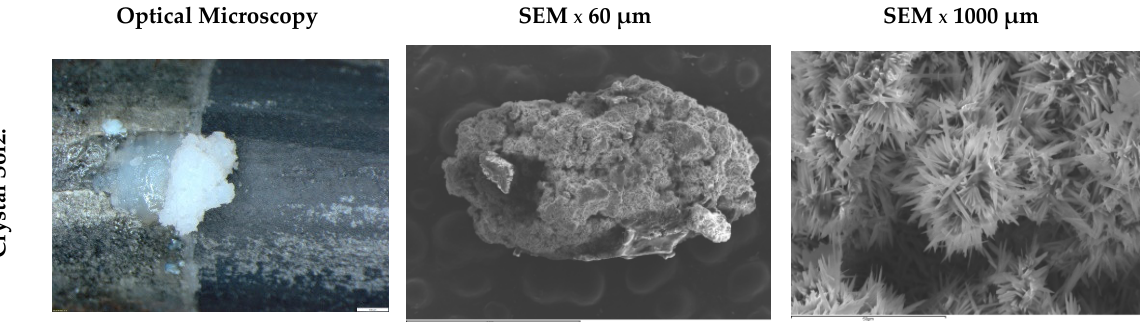
Figure 9. Optical microscopy and SEM crystal results Ca(Zn(OH) 3 ) 2 Solution 2.